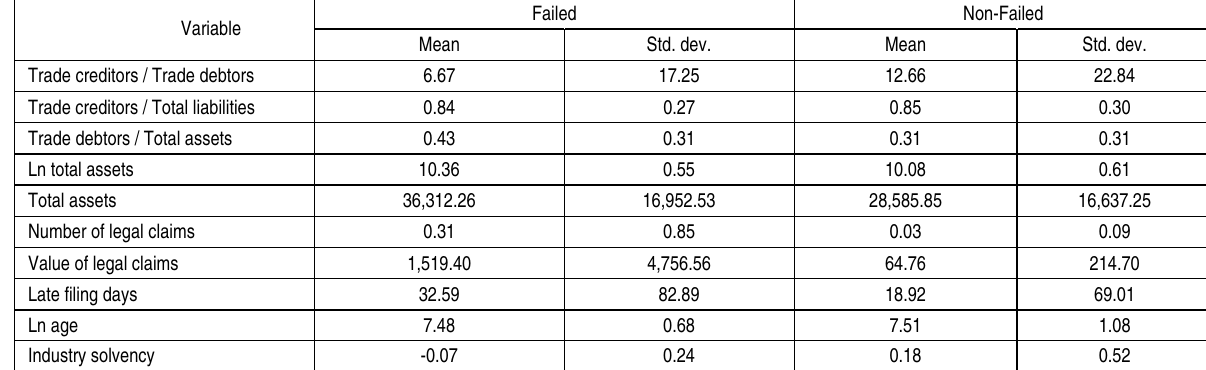
Table A.1 (cont.). Descriptive statistics of the quantitative predictor variables